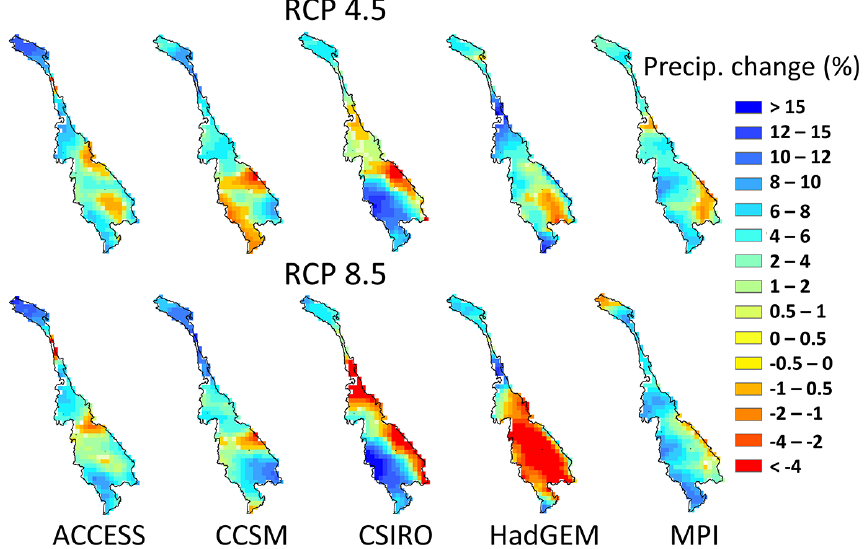
Figure 4. Projected change in total annual precipitation (%) under future climate (2036–2065) compared to the baseline climate